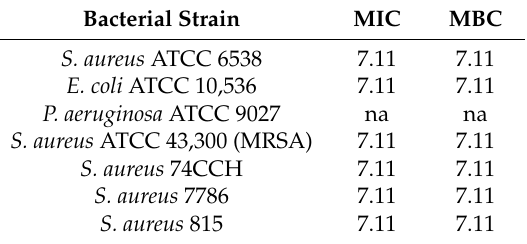
Table 2. Minimal inhibitory concentrations (MICs) and minimal bactericidal concentrations (MBCs) of HEO (expressed as mg/mL) against Gram-positive and Gram-negative bacteria. Bacterial